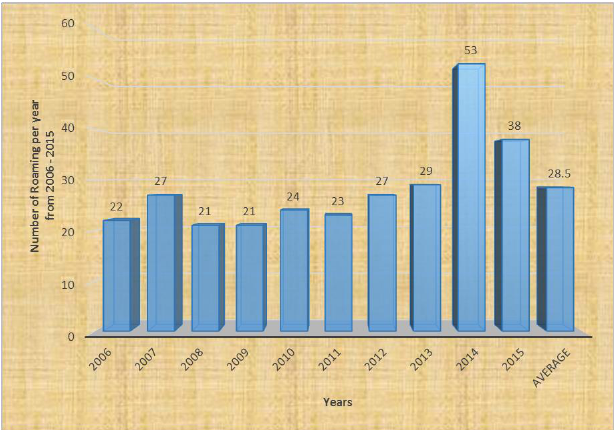
Figure A.1. Total and Average Annual Roaming Statistics in a Decade